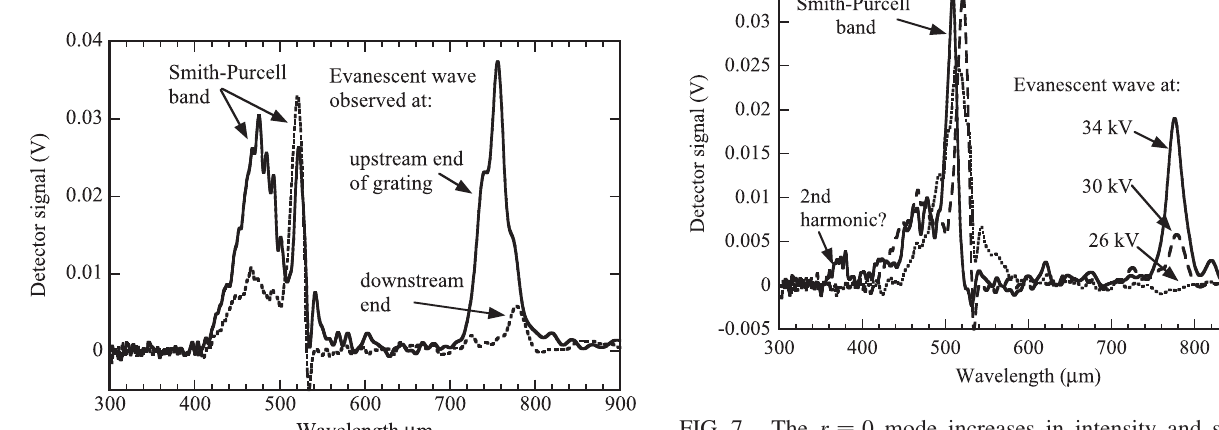
FIG. 7. The r ¼ 0 mode increases in intensity and shows a slight shift to shorter wavelength with increasing voltage as expected. In the 34 kV spectrum there is another peak near 375 (cid:4) m , the second harmonic of the r ¼ 0 mode. Its presence may suggest beam bunching. Spectra were collected at the downstream end of the grating.